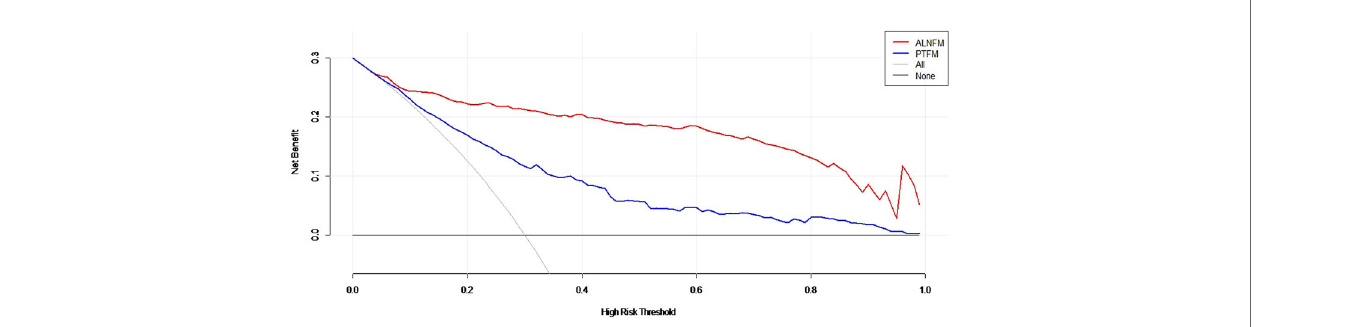
FIGURE 6 | Decision curve analysis of the two nomograms. The net bene fi t is shown by the y-axis. The advantages minus disadvantages are equal to the net bene fi ts. When the risk threshold probability is between 0.07 and 0.99, the ALNFM nomogram (red curve) showed more bene fi t for patients for predicting ALN status than the PTFM nomogram or the treat-all and